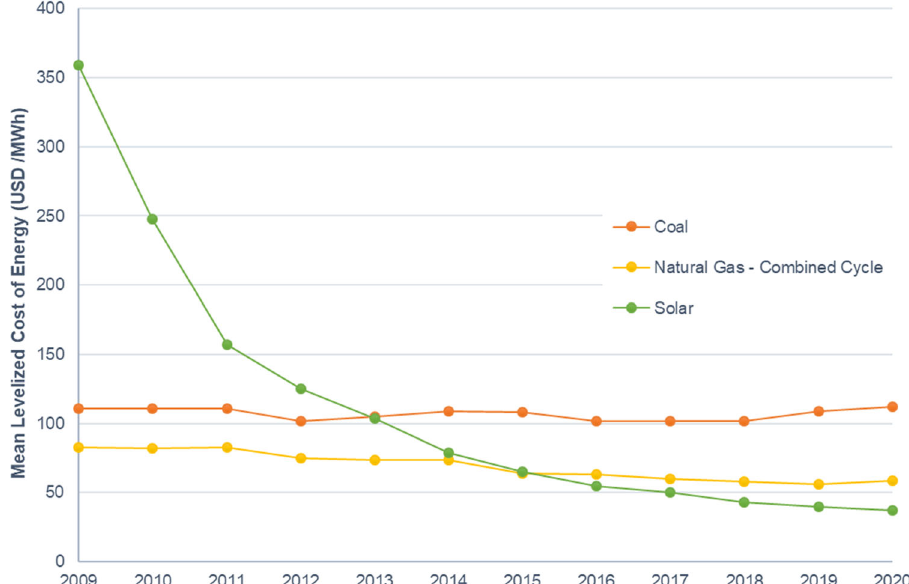
Fig. 6 Mean trends in levelized cost of coal, natural gas, and solar power. Modi fi ed graph from Lazard showing the historic mean levelized energy costs of coal, natural gas, and solar power since 2009 53 . In 2020, the mean levelized cost for energy sources in USD per MWh of solar (green) is shown to be lower that both natural gas (yellow) and coal